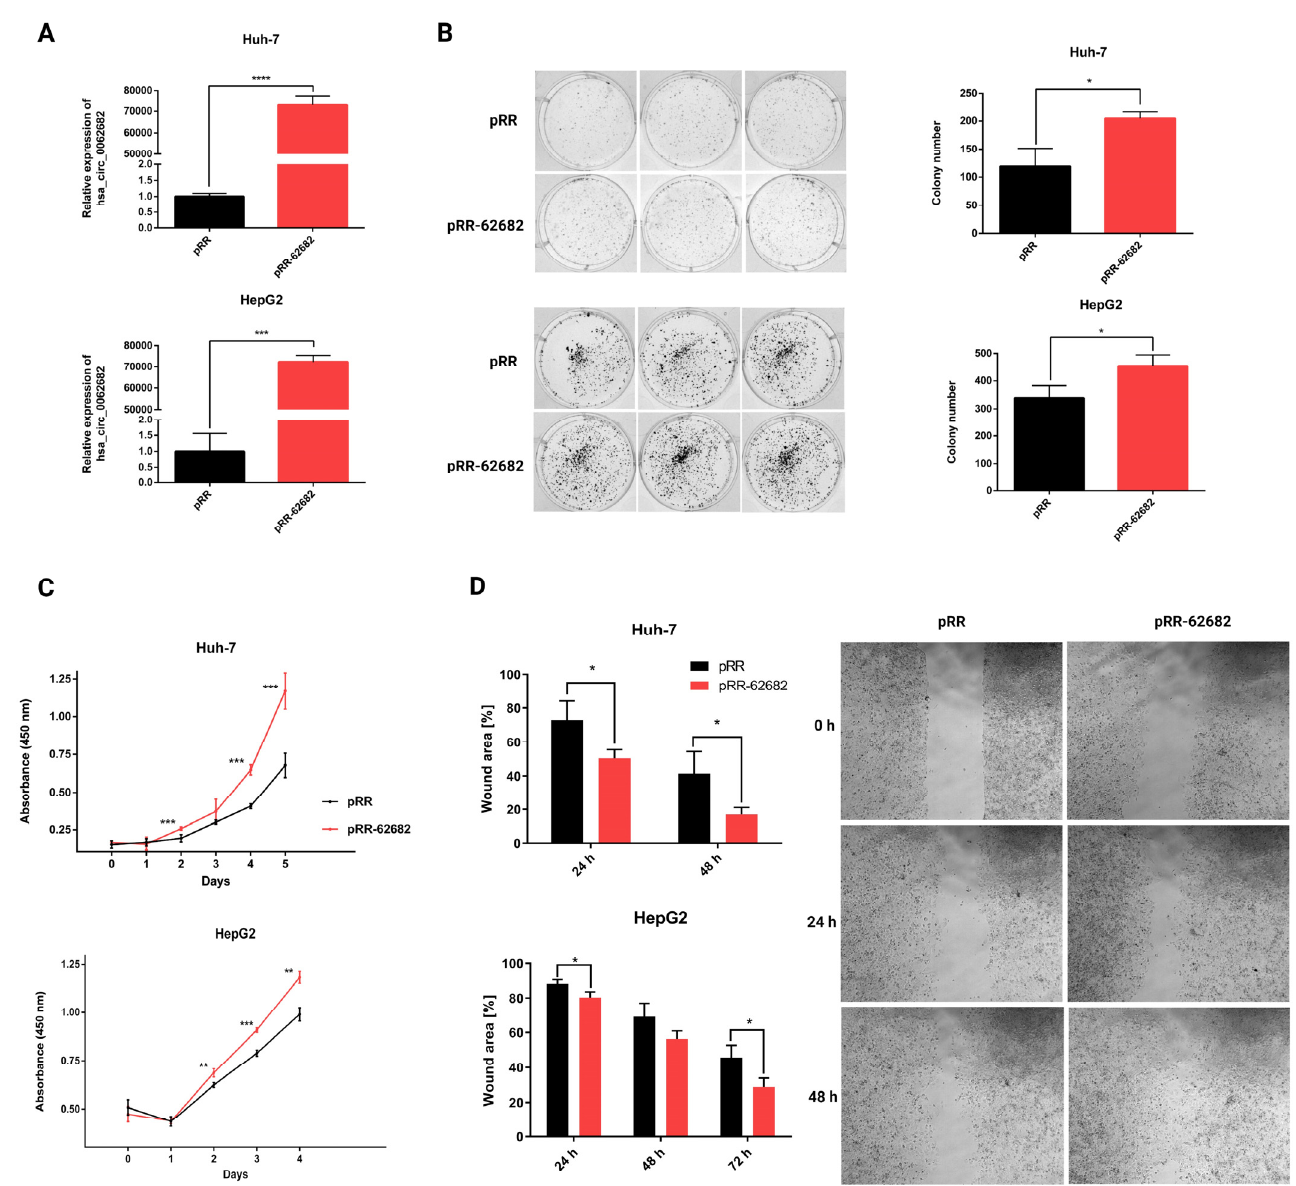
Figure 2. Transient overexpression of circular RNA hsa_circ_0062682 promoted the oncogenic poten- tial of HCC model cell lines. ( A ) Relative expression of hsa_circ_0062682 in transiently overexpressing Huh-7 ( up ) (n = 3) and HepG2 ( down ) cell line (n = 3); ( B ) colony forming assay in hsa_circ_0062682-overexpressing Huh-7 (left) (n = 3) (10,000 cells) and HepG2 ( right ) cell lines (n = 3) (5000 cells); ( C ) proliferation of hsa_circ_0062682-overexpressing Huh-7 ( up ) (n = 4) and HepG2 ( down ) cell lines (n = 4); ( D ) wound healing assay of hsa_circ_0062682-overexpressing Huh-7 ( up ) (n = 4) and HepG2 ( down ) (n = 4) cell lines; representative images of Huh-7 migration are shown on the right; representative images of HepG2 migration can be found in Supplementary Materials; pRR–empty plasmid, pRR-62682–plasmid for hsa_circ_0062682 overexpression; results are represented as averages and error bars represent standard deviation. * p -value ≤ 0.05; ** p -value ≤ 0.01; *** p -value ≤ 0.001; **** p -value ≤ 0.0001, Student’s t- test.